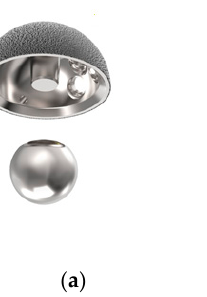
Figure 3. Tapers visually evaluated for corrosion: Acetabular Taper ( a ) and Femoral Taper ( b ).